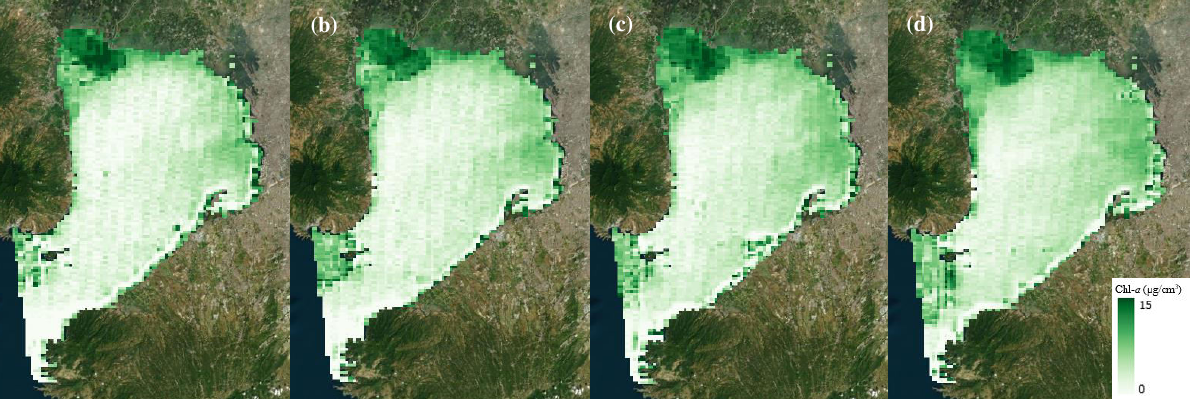
Figure 9. Chl- a maps for September 26, 2019 using the Wet model: (a) 9:10, (b) 9:30, (c) 9:50, and (d) 10:10 AM.